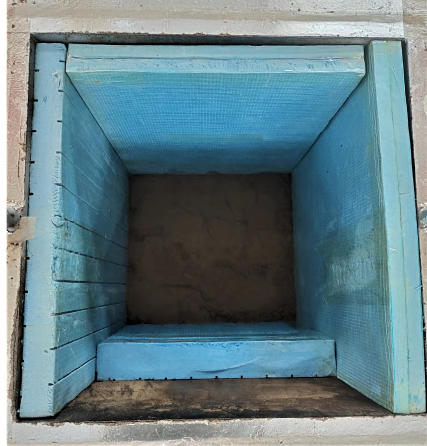
Figure 4. Top view of the model box.